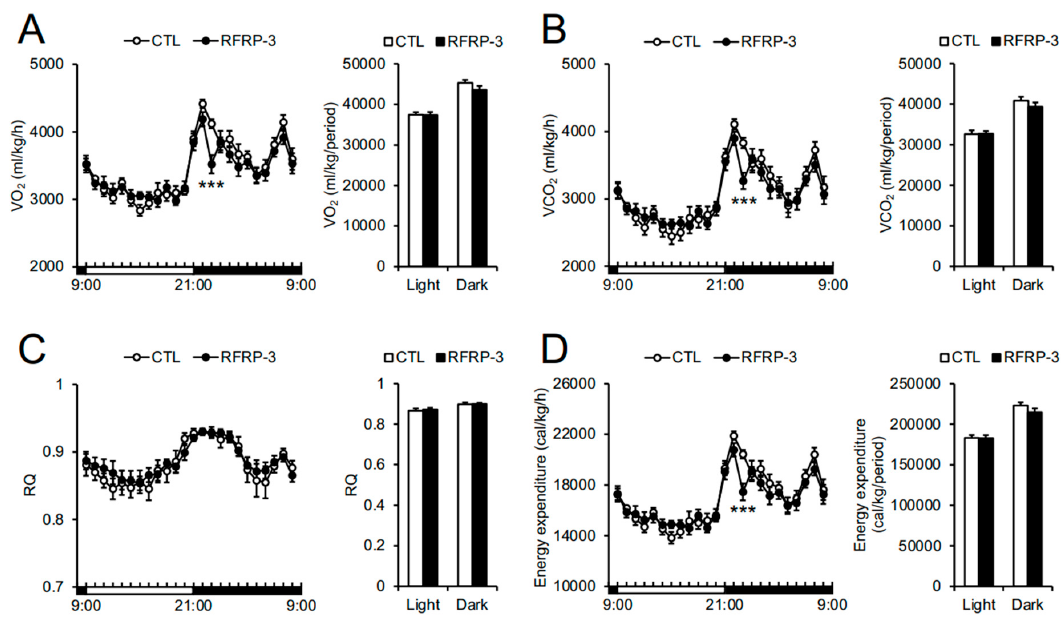
Figure 3. The effects of chronic intracerebroventricular (i.c.v.) infusion of RFamide-related peptide-3 (RFRP-3) on O 2 /CO 2 metabolism hourly. ( A ) O 2 consumption (VO 2 ) measured in the metabolic cage. ( B ) CO 2 production (VCO 2 ) measured in the metabolic cage. ( C ) The respiratory quotient (RQ) measured in the metabolic cage. ( D ) Energy expenditure calculated by VO 2 and VCO 2 . Each value represents the mean ± standard error of the mean. n = 7–8; *** p < 0.005.